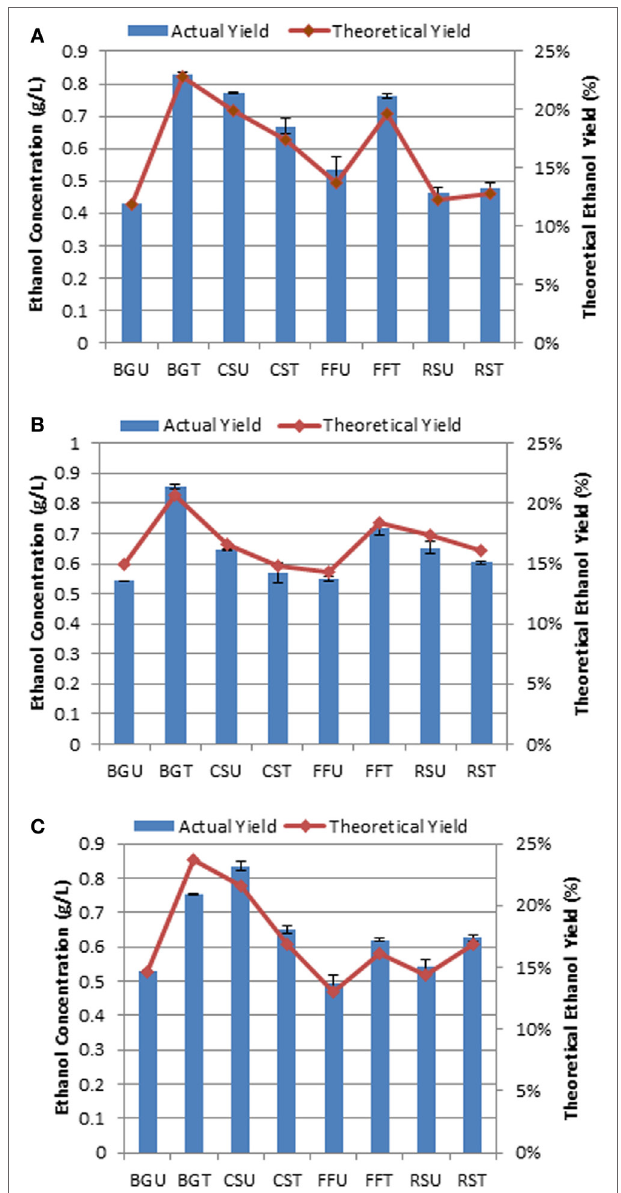
FigUre 6 | Fermentation of selected lignocellulosic substrates for bioethanol production and estimated at three intervals (a) 96 h, (B) 120 h, and (c) 144 h. BGU, untreated sugarcane bagasse; BGT, hydrothermally treated sugarcane bagasse; CSU, untreated cassava aerial parts; CST, hydrothermally treated cassava aerial parts; FFU, untreated ficus fruits; FFT, hydrothermally treated ficus fruits; RSU, untreated rice straw; RST, hydrothermally treated rice straw. Bar indicates ±